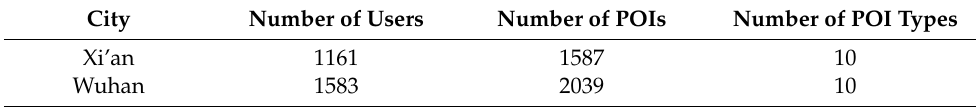
Table 2. Introduction to other data.